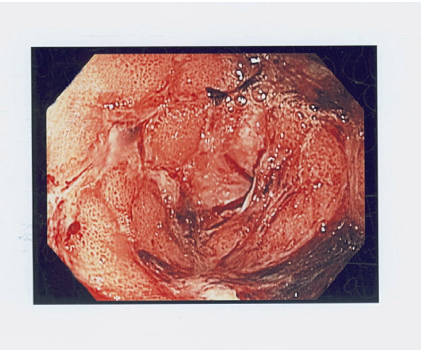
Figure 1: Endoscopic image showing diffuse, severe gastric ulceration.